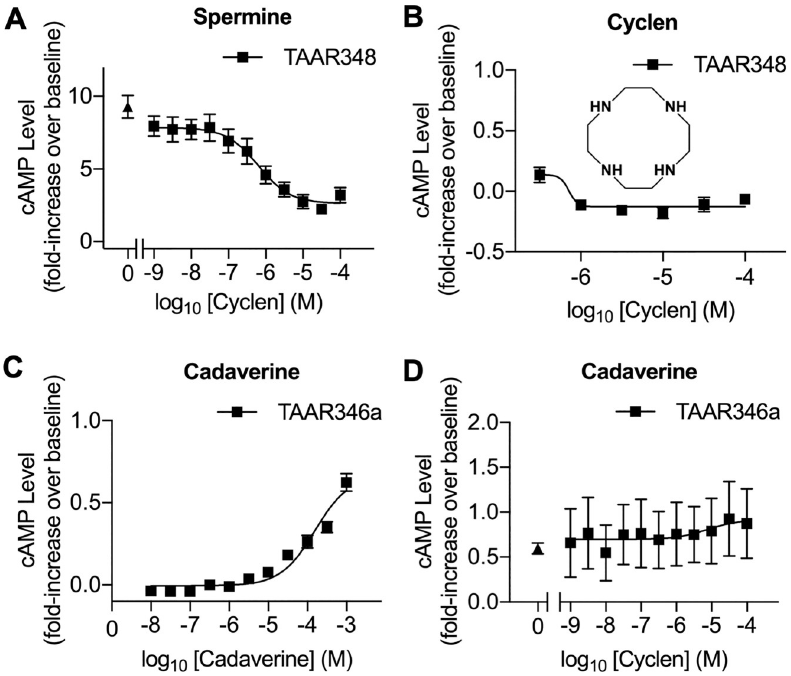
Fig 4. Cyclen antagonized spermine-induced cAMP responses to receptor TAAR348. (A) Cyclen treatment inhibited cAMP production induced by 0.1 mM spermine in TAAR348-expressing HEK293T cells as measured with a TR-FRET assay and normalized to the cAMP level in buffer-treated cells (mean ± SEM, n = 5). The filled triangle represents cAMP production induced by 0.1 mM spermine in the cells without exposure to cyclen. Fold increase over basal was calculated as [(measured cAMP − basal cAMP) � basal cAMP] − 1. (B) Cyclen did not induce cAMP production in HEK293T with TAAR348 (mean ± SEM; reads from triplicate wells). (Inset) Structure of cyclen (1,4,7,10-tetraazacyclododecane). (C) Cadaverine induced cAMP production in a concentration-dependent manner in HEK293T cells expressing another sea lamprey TAAR-like gene—TAAR346a (mean ± SEM, n = 5). (D) Cyclen treatment did not inhibit cAMP production induced by 1 mM of cadaverine in HEK293T cells expressing TAAR346a. The filled triangle represents the cAMP production induced by 1 mM of cadaverine in the cells without exposure to cyclen (mean ± SEM, n = 5). Underlying data are available in S1 Data. cAMP, cyclic-adenosine monophosphate; HEK293T, human embryonic kidney 293T; TAAR, trace amine-associated receptor; TR-FRET, time-resolved fluorescence energy